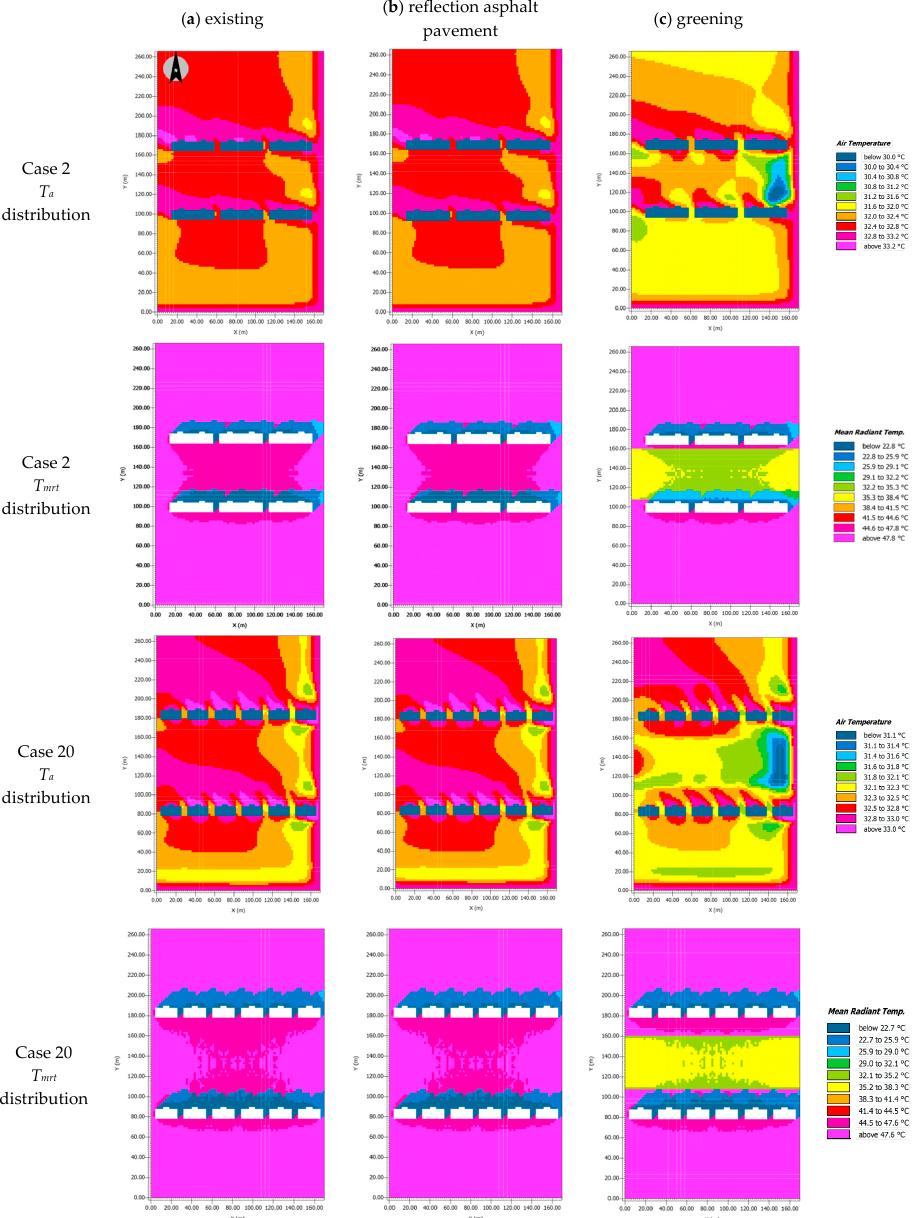
Figure 8. Outdoor thermal comfort results of applying greening (3 m trees) and reflection asphalt pavement. Table 9. Results of applying the heat island mitigation plan.